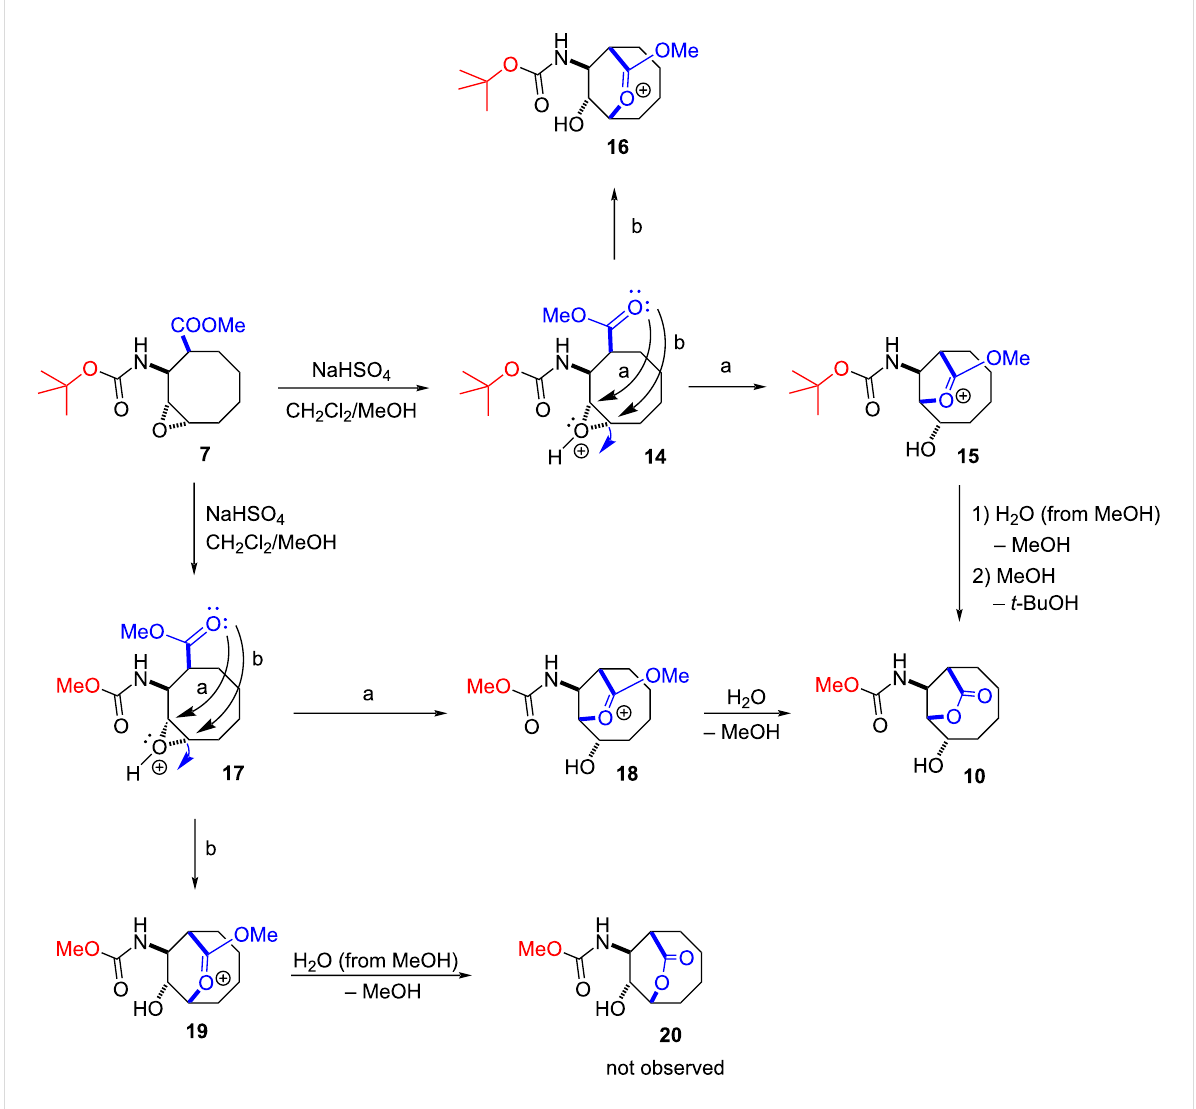
Scheme 5: Suggested mechanism for the reaction of epoxide 7 with NaHSO 4